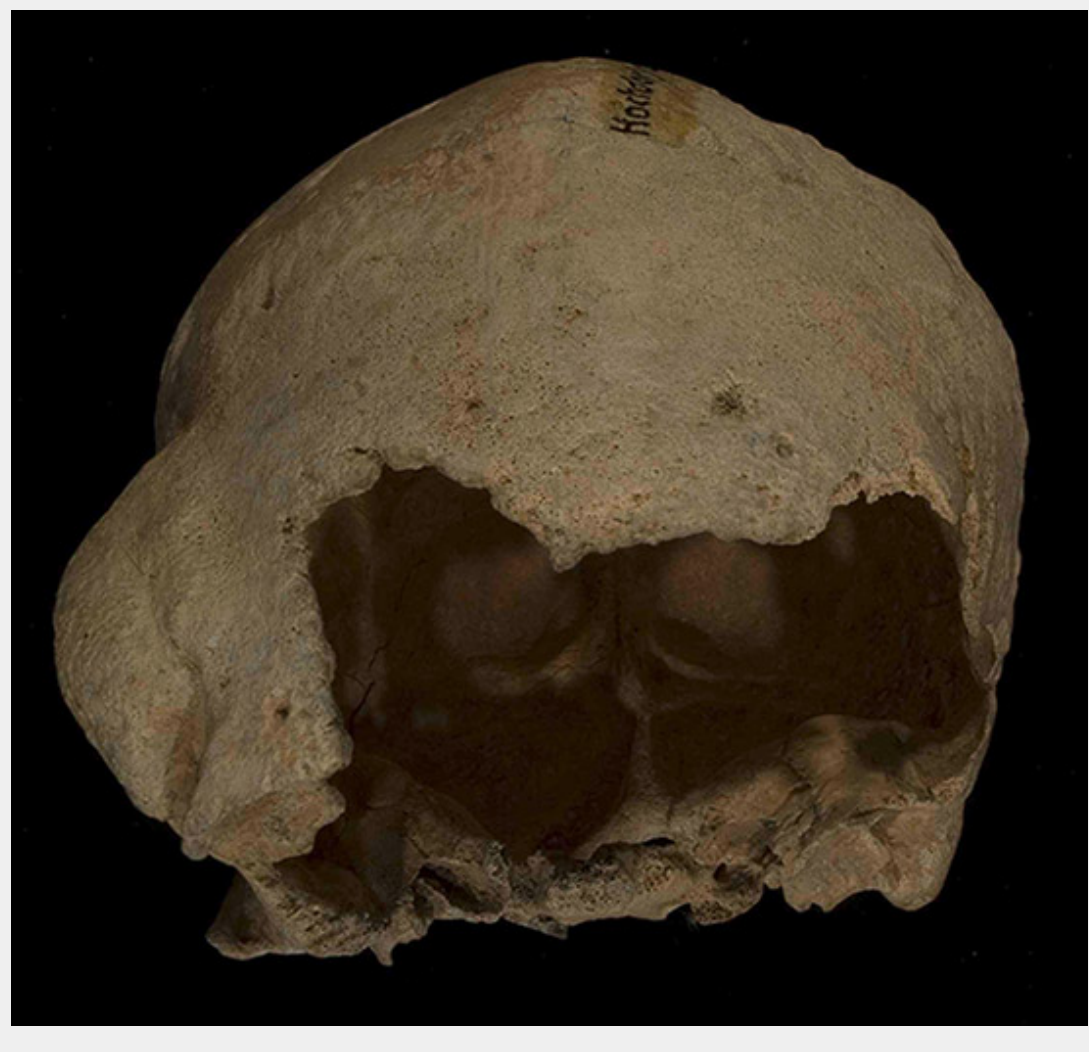
Figure 2 Skull with intensely calcified bone proliferation at the right side of the os